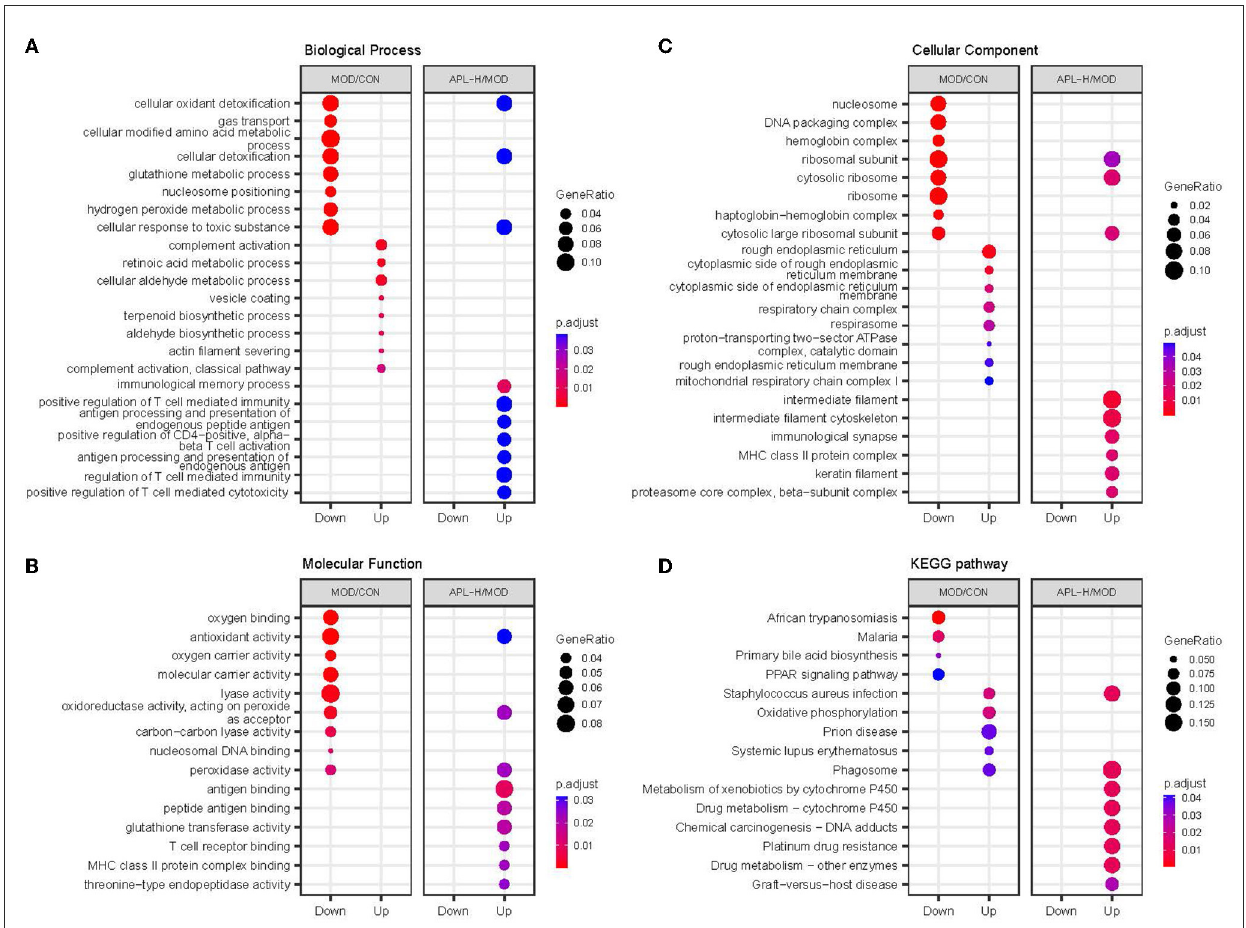
FIGURE8 GO enrichment and KEGG pathway analysis of different groups. (A) Biological process analysis; (B) Molecular function analysis; (C) Cellular component analysis; (D) KEGG pathway analysis.